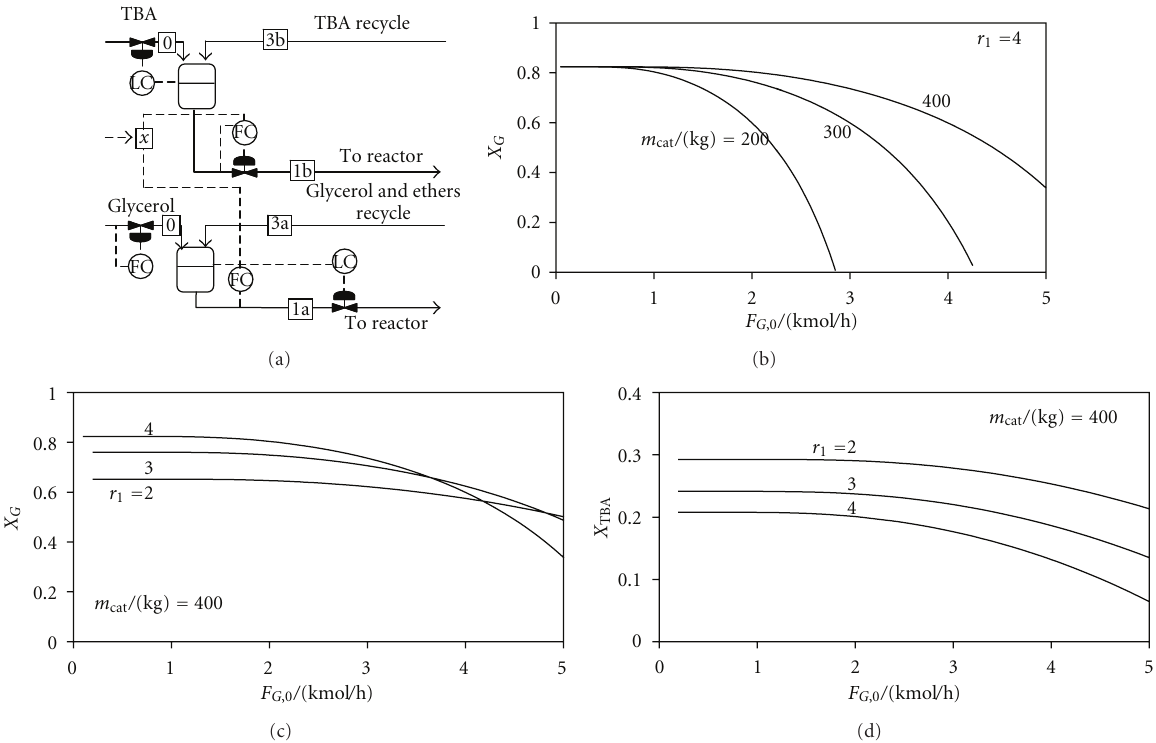
Figure 4: Control structure CS3. Reactants conversions versus fresh glycerol flow rate, for di ff erent values of catalyst mass and ratio between reactor-inlet flow rates.